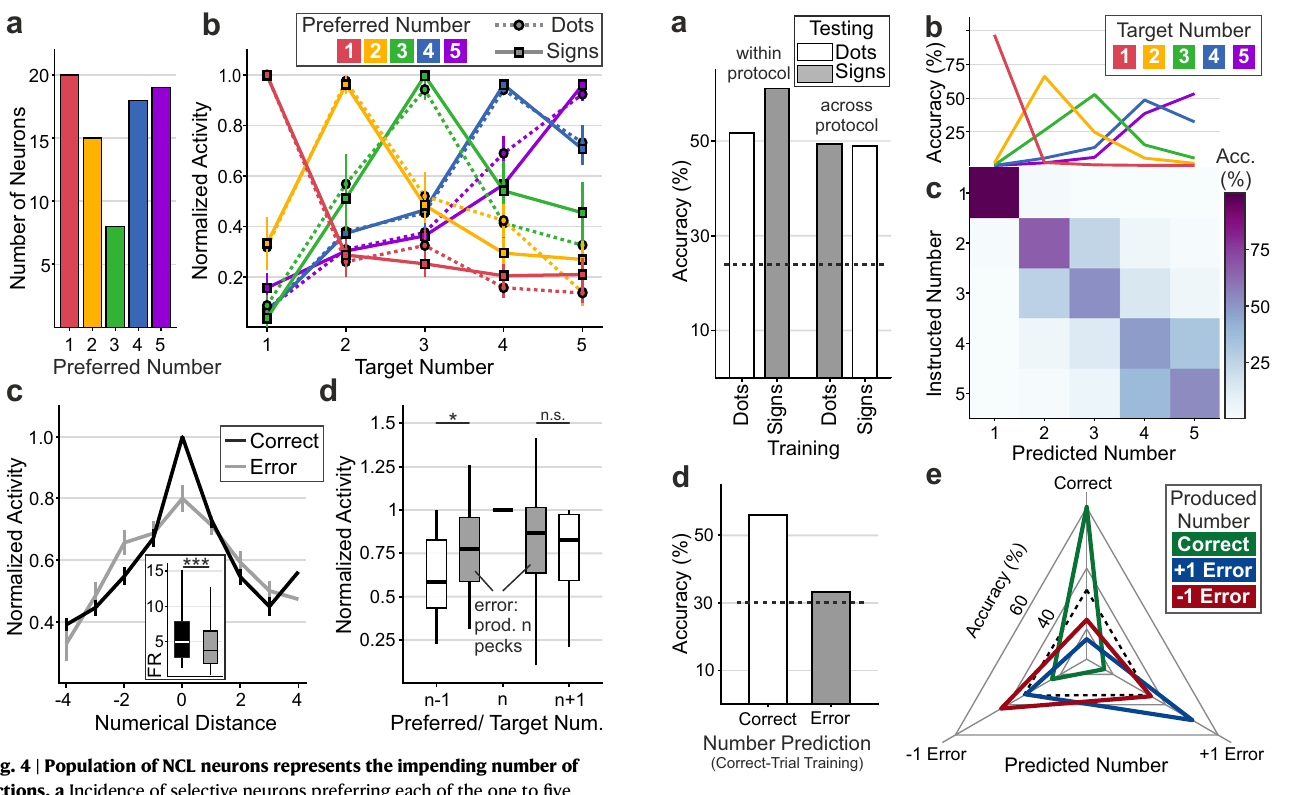
Fig.5|Theneuronpopulationpredictsthecrows ’ impendingnumberofpecks. a Accuracy of within- and across-protocol classi fi er prediction performance. Average accuracy for prediction of target number from fi ring rate of the sampled NCLpopulationduringthemotorplanningperiod.Within-(trainedontrialsfroma protocol and tested on new trials from the same protocol) and across-protocol performances (trained on trials from a protocol and tested on new trials from the other protocol) are shown. Dotted lines represent 95th percentile of shuf fl ed label classi fi er performance. Error bars indicating SEM are too small to be depicted. b Performance of SVM classi fi er. Curves show the classi fi cation performance for each target number (color coded). Error bars indicating SEM are too small to be displayed. c Confusion matrix showing the accuracyoftheclassi fi er predicting the number of impending pecks in relation to the instructed number of pecks. The main diagonal describes correct classi fi cations. Values from rows of the confusion matrix result in the curves in b . d Classi fi er accuracies for predicting correct and incorrectnumberofpeckswhen the classi fi er wastrainedon fi ring rates of correct trials from the motor planning period. Dotted lines represent 95th percentile of shuf fl ed label classi fi er performance. Error bars indicating SEM are too small to be depicted. e Classi fi er accuracies (spanned in three-dimensional space) for pre- dicting whether the crows would generate less ( − 1 error) or more pecks (+1 error) than instructed (correct) based on fi ring rates during the motor planning period.